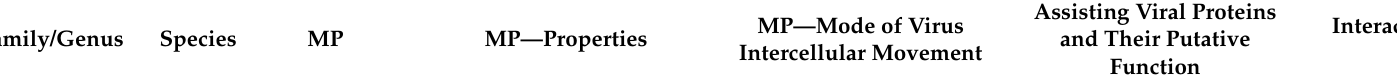
Table 1. General details of movement proteins of some of the most worked out viruses across